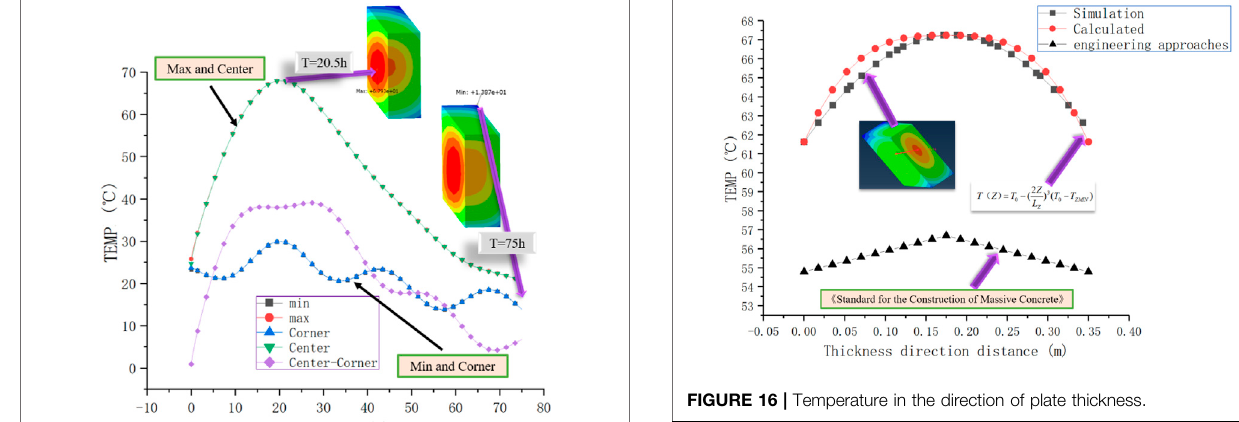
FIGURE 16 | Temperature in the direction of plate